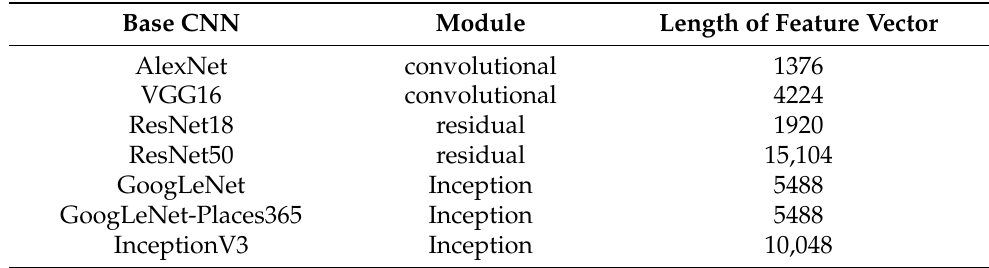
Figure 2. Illustration of frame-level feature extraction. Table 2. Summary about the applied CNNs. The applied modules in feature extraction and the length of the extracted frame-level feature vectors are